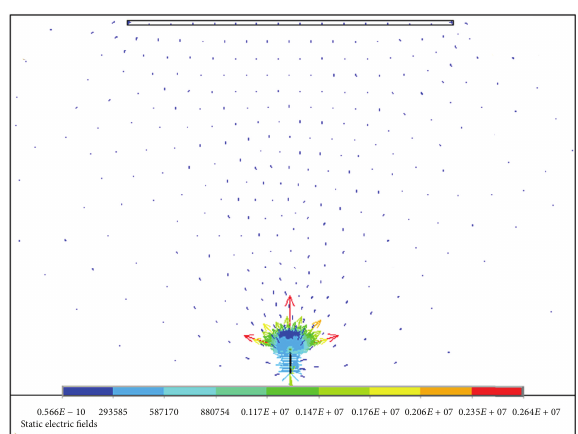
Figure 3: Vector distribution of the electric field intensity.